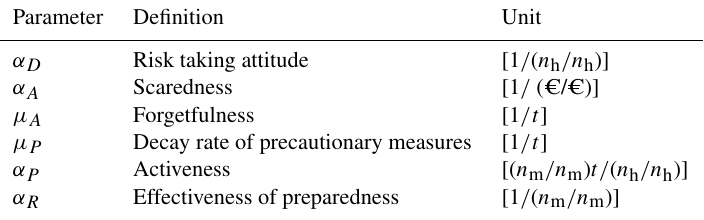
Table 1. Model parameter description and units ( n h = number of households, n m = number of precautionary measures)